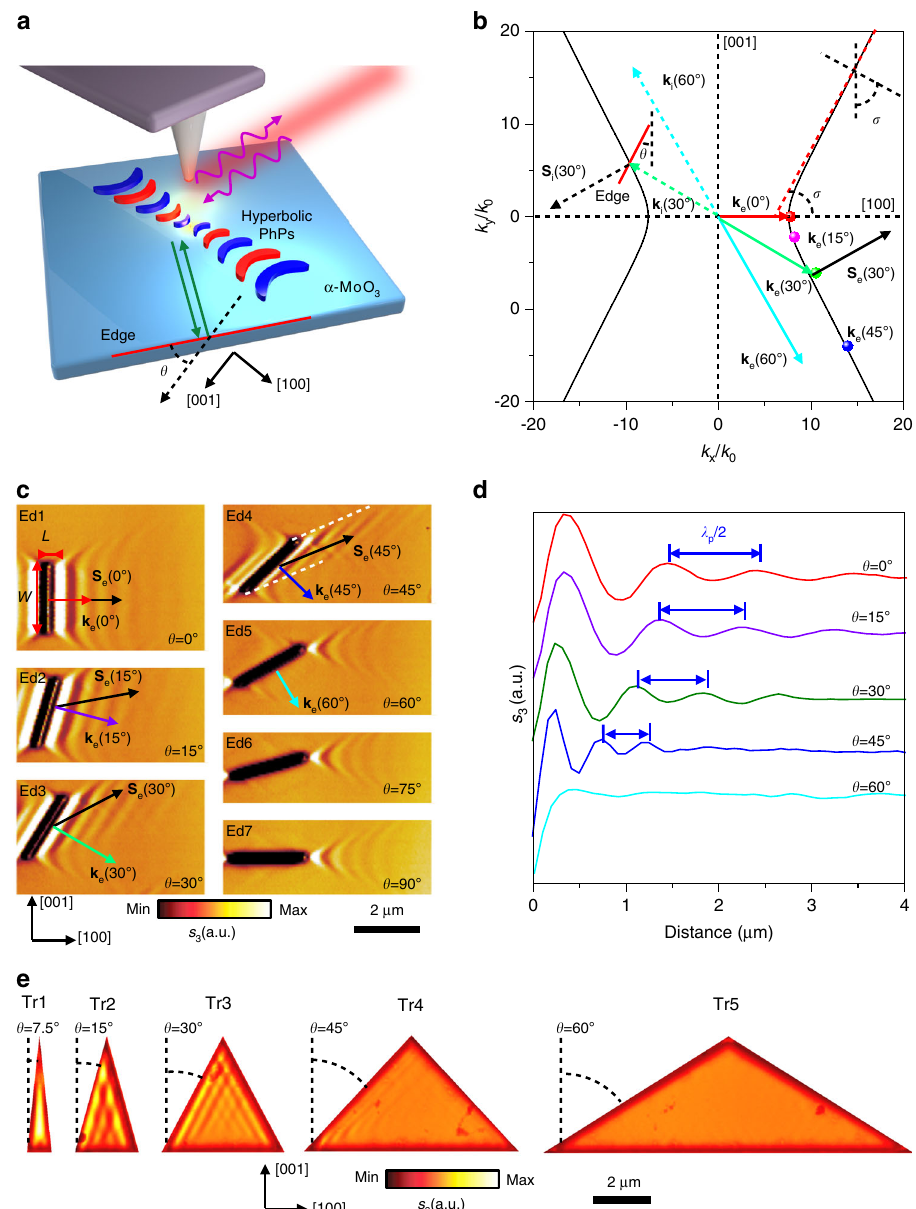
Fig. 1 Edge-tailored hyperbolic PhPs in α -MoO 3 . a Schematic diagram of edge-tailored PhPs in α -MoO 3 . The edge orientation is de fi ned as angle θ with respect to the [001] direction. Green arrows indicate the incident PhPs waves launched by the laser-illuminated (purple curve arrows) AFM tip and re fl ected by the edge (red line). b Angle-dependent k e isofrequency contour of PhPs in α -MoO 3 at ω = 889.8 cm − 1 . The solid lines and points stand for experimental results concluded from Fig. 1c. The green and black dotted arrows illustrate the incidence wavevector k i and Poynting vector S i , respectively. Generally, k i and S i are non-collinear. The re fl ected Poynting vector S e (solid arrows) is not parallel to the re fl ected wavevector k e (different color solid arrows) but antiparallel to S i . σ is the open angle. c Real-space imaging of edge-tailoring PhPs at angle-dependent α -MoO 3 edges (length L : 2.5 µ m; width W : 200 nm; sample thickness d : 210 nm, L and W de fi ned in the Ed1). d s-SNOM line traces along the direction perpendicular to the edges in Ed1-Ed5. e Near- fi eld amplitude s ( ω ) of PhPs on isosceles triangle α -MoO 3 nanocavities with bottom edge perpendicular to the [001] crystal direction (height length: 4.33 μ m; thickness: d = 175 nm); The angles between adjacent sides of the series of triangles with respect to the [001] direction are approximately 7.5°, 15°, 30°, 45°, and 60°,